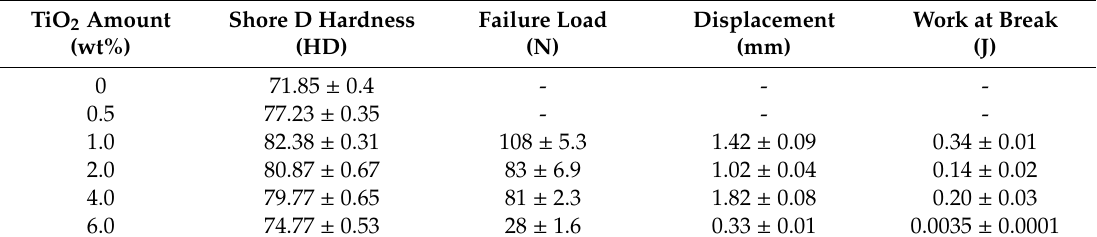
Table 1. Static hardness and tensile test of the nanocomposite joints at di ff erent percentages of filler. For a filler amount of 0.5 wt%, the weld process was not obtained.